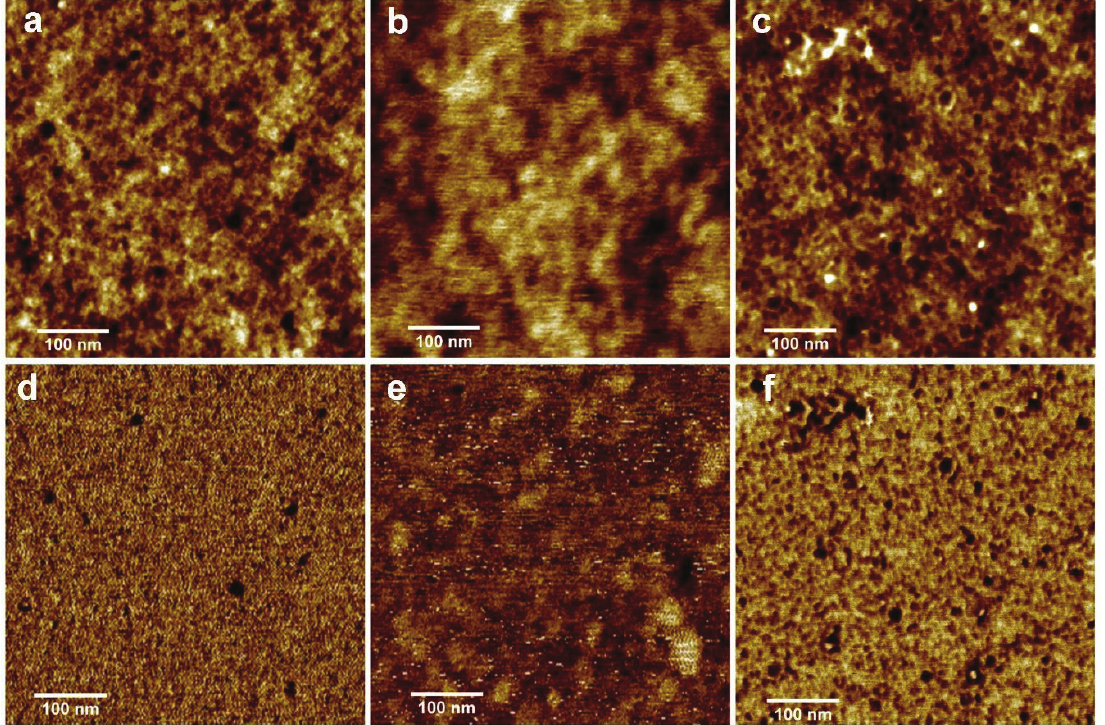
Figure 4: AFM height (a-c) and phase (d-f) of as-casted film (a,d), after DIA (b,e) and after acid vapor treatment followed by washing (c,f) for Polymer 1.